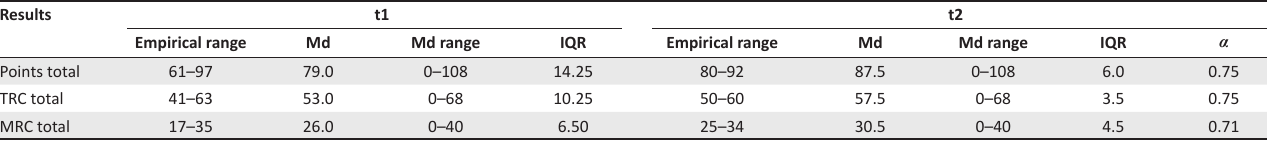
TABLE 3: Results in total and by competency. Results